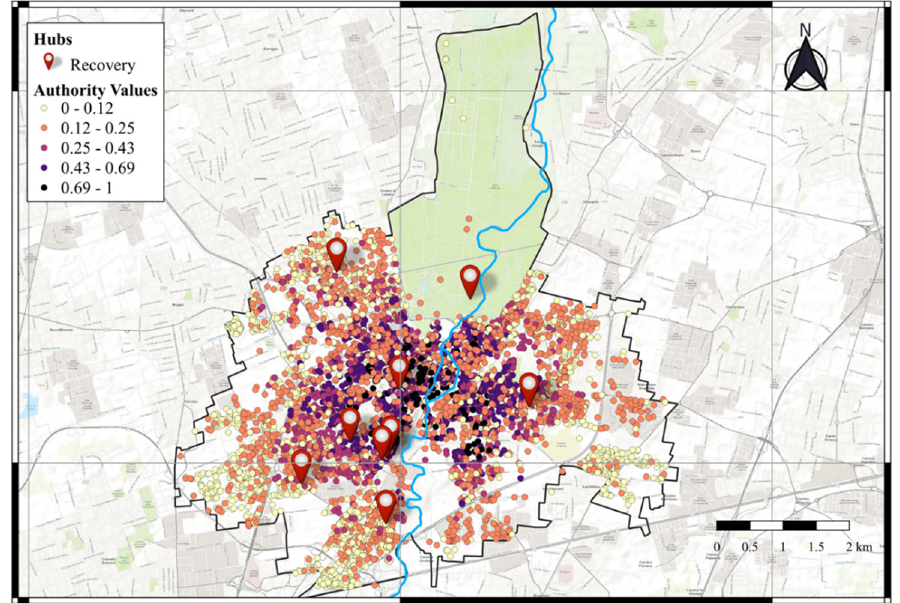
Figure 7. Map of the authority values.